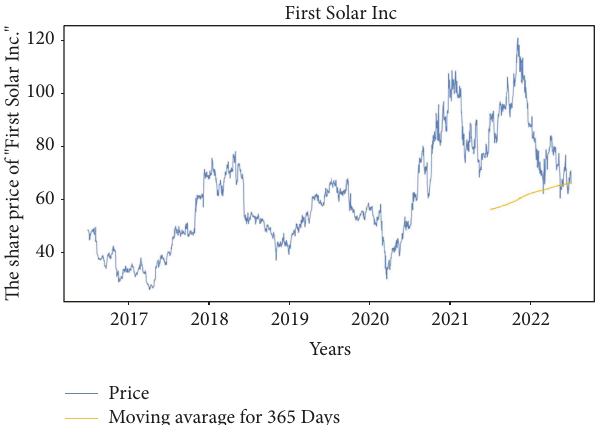
Figure 3: Predicting the stock price of First Solar Inc (The blue color shows the real stock price, yellow color shows projected stock price). Sources: authors.